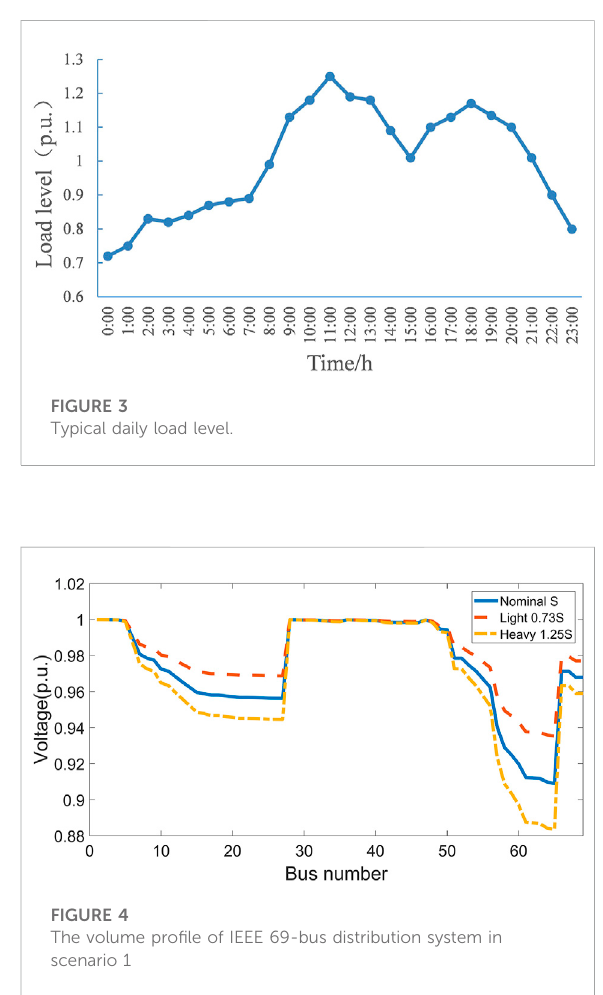
Figure 3. According to Figure 3, within 24 h, the load at 15:00 is the nominal load, the load at 1:00 is light load level, the load at 11: 00 is heavy load level, and the load at 1:00 and 11:00 are 0.73 times and 1.25 times of the nominal load respectively.